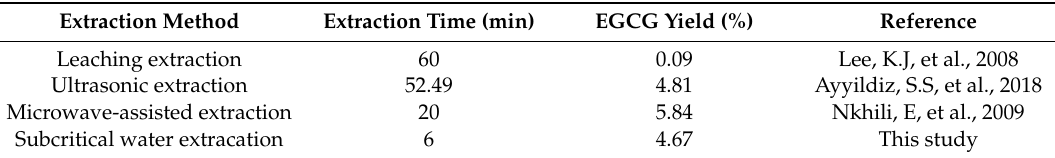
Table 4. Comparison of time and EGCG yield with reported extraction